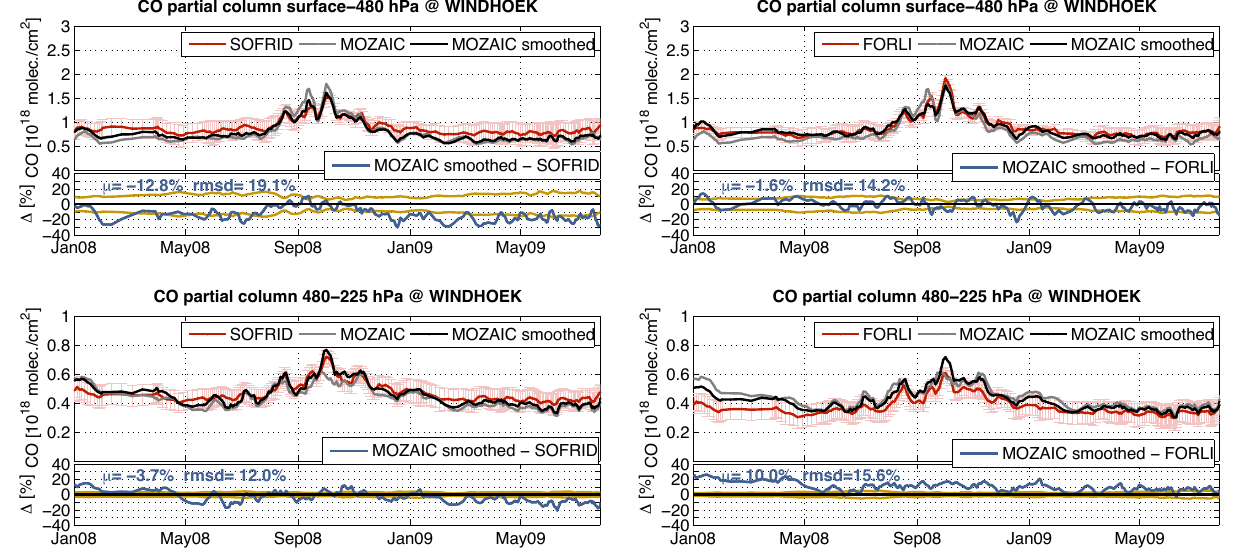
Fig. 6. As in Fig. 5 for Windhoek. Note the different timescale (MOZAIC flights to Windhoek stopped in July 2009).